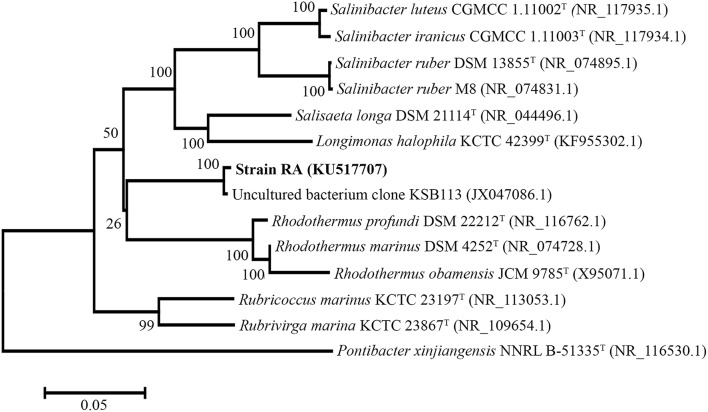
Phylogenetic tree of strain RA and other Rhodothermaceae genera based on 16S rRNA sequencing. Pontibacter xinjiangensis NNRL B-51335T was selected as the out group (https://figshare.com/s/4f470ab9ce3727bf4392).